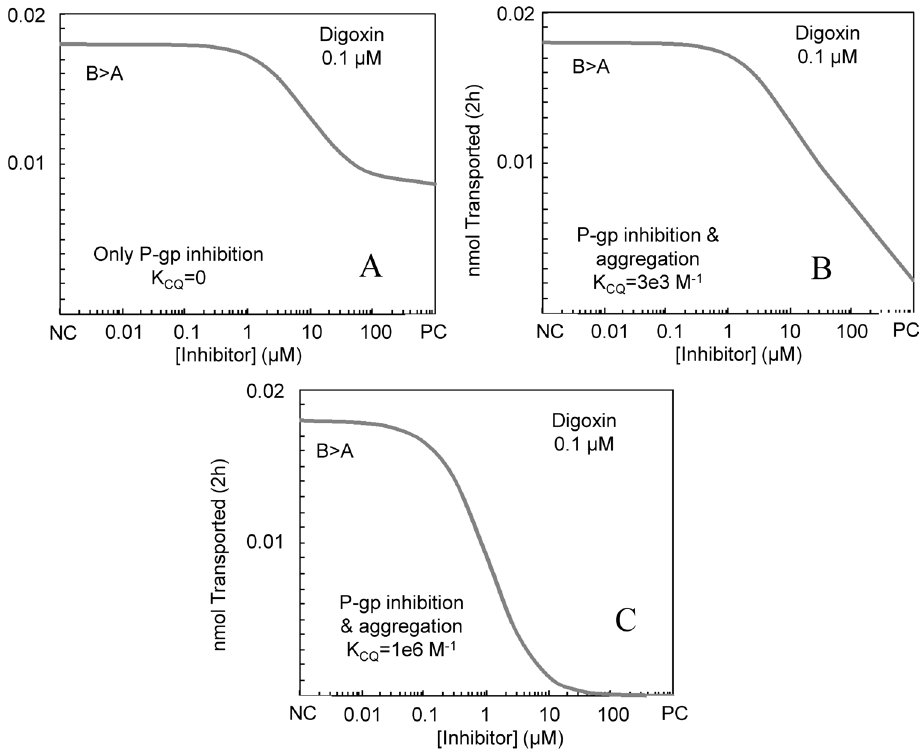
Figure 4. Simulated inhibition of 0.1 mmmm M digoxin B . A transport across the MDCK-MDR1-NKI cells by an inhibitor under three scenarios of inhibitor binding to digoxin in the donor and receiver chambers. Fig. 4A shows the case where K CQ =0, i.e. digoxin transport was inhibited solely by P-gp inhibition. The curve is sigmoidal. Fig. 4B shows the case where K CQ =3e3 M 2 1 , i.e. digoxin transport was inhibited by P- gp inhibition and by loss of free digoxin in the donor chamber due to heterodimerization to the inhibitor. The curve is not sigmoidal. Fig. 4C shows the case where K CQ =1e6 M 2 1 , i.e. digoxin transport was inhibited by P-gp inhibition and by loss of free digoxin in the donor chamber due to strong heterodimerization to the inhibitor. The curve is sigmoidal with a large inhibitor concentration plateau, i.e. PC plateau, of no transported digoxin, since there is no free digoxin.